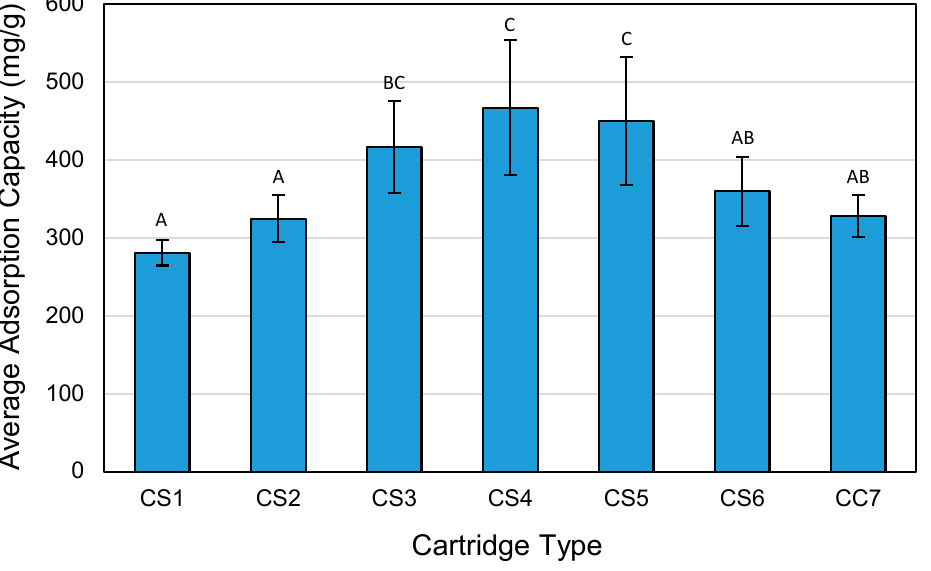
Figure 8. Average adsorption capacity by cartridge type. Shown with error bars. The letters above each bar represent differences or similarities between cartridge types. Cartridge types with the same letter are not significantly different by average comparison. Cartridge types with a different letter are significantly different by average comparison. Cartridge type (ACF composition): CS1 (100% AF1); CS2 (100% AF2); CS3 (100% AF3); CS4 (100% AF4); CS5 (100% AF5); CS6 (100% AF6); CC7 (71% AF1/29% AC1).